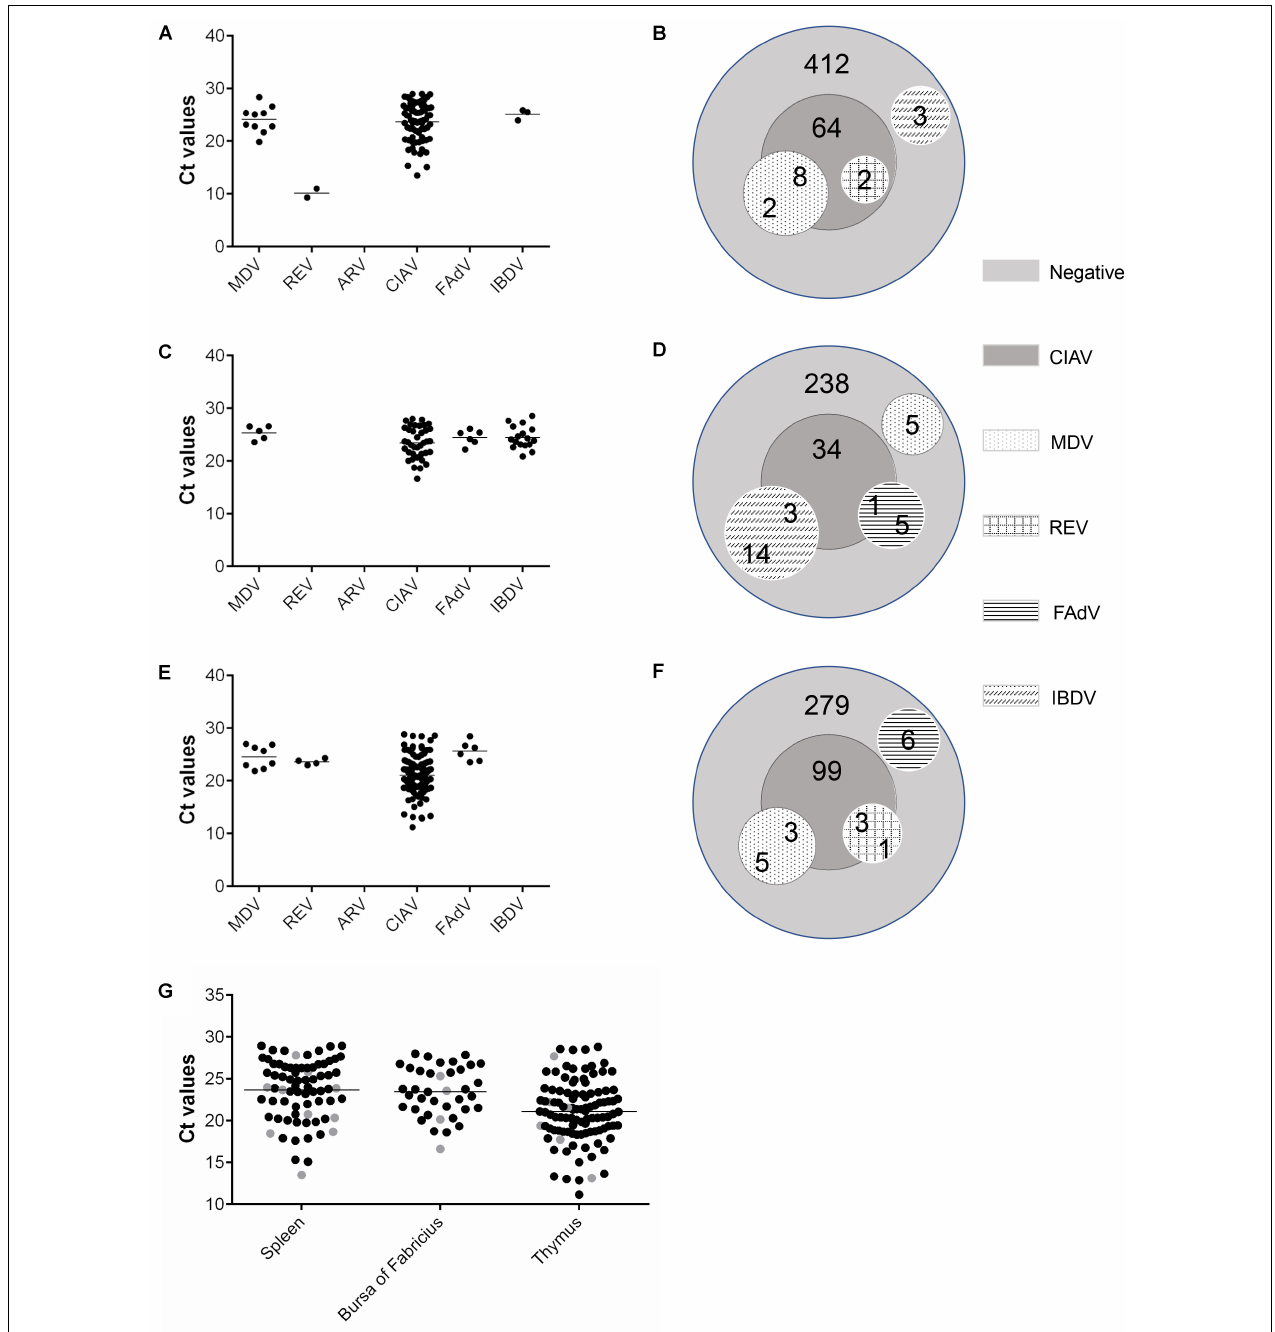
FIGURE 3 | Virus detection results from the MRT-qPCR assay of the 1,187 clinical samples. For the spleen (A,B) , bursa of Fabricius (C,D) , and thymus (E,F) samples, the Ct value of positive samples for each virus are shown with scatter plots (A,C,E) . Each dot represents the mean Ct value of three duplicate in a positive sample. Coinfection samples are shown with Venn diagrams (B,D,F) . (G) Distribution of Ct values of CIAV in three tissues under simple infection and coinfection. Each dot represents the mean Ct value of three duplicates in a positive sample. The Ct values of CIAV single infection are shown with black dots. Coinfection of CIAV with different viruses is shown with gray